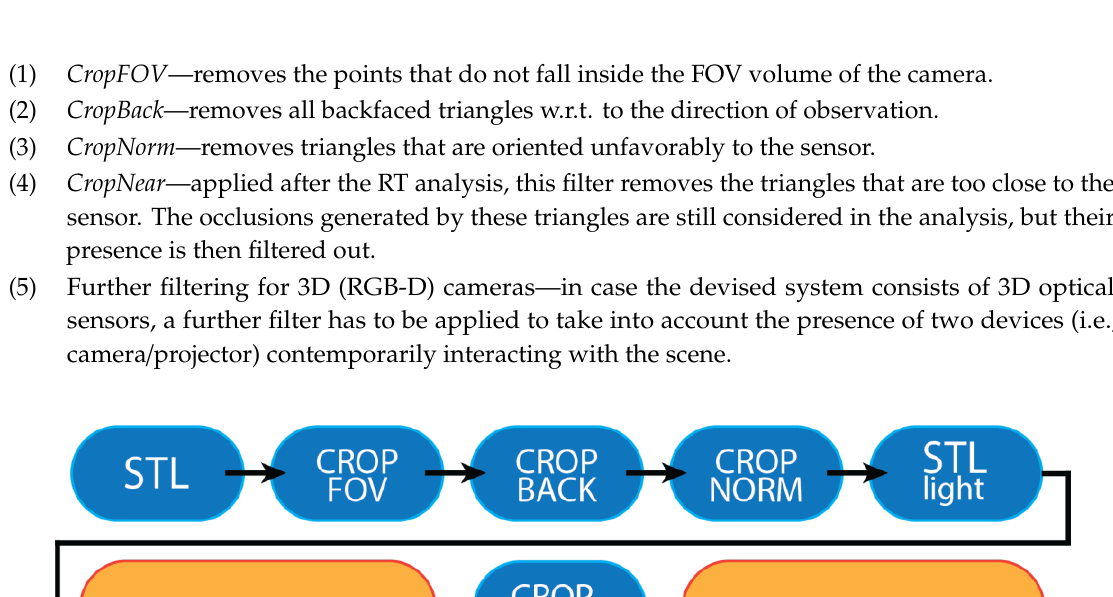
Figure 2. Visibility analysis framework: filters applied to the 3D model in order are depicted in blue, the main elements of the procedure (Ray Tracing analysis and the desired result — the Visibility Map (VM)) are depicted in orange.